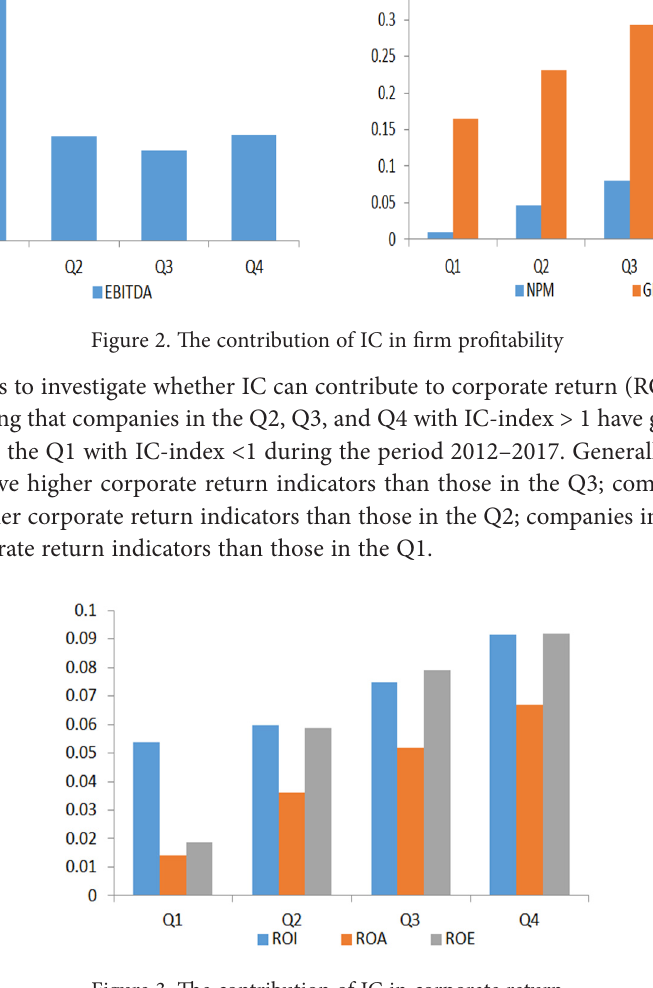
Figure 3. The contribution of IC in corporate